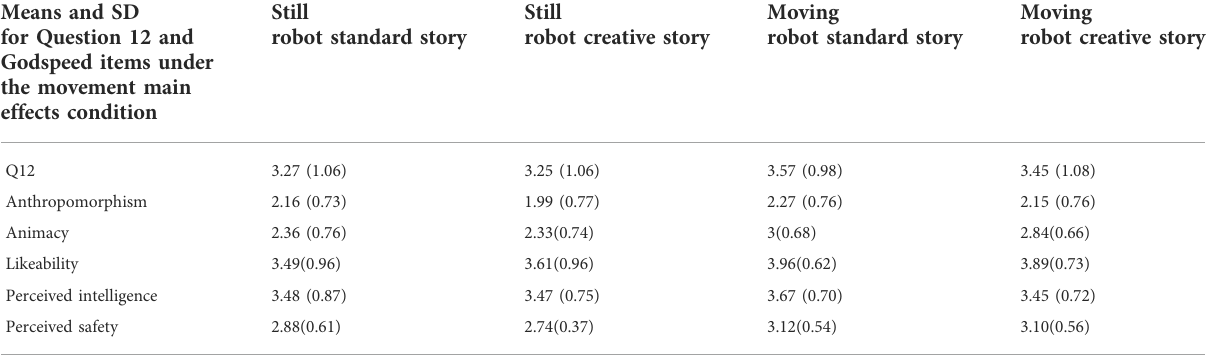
TABLE 3 Pearson ’ s correlations among the CPI, CSE, and SSCS scores. The scores are internally consistent. Pearson ’ s Correlations among the CPI, CSE, and SSCS scores for humans and robots ( p <0